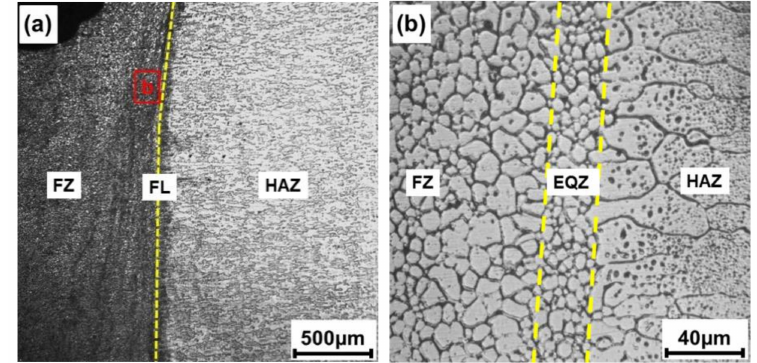
Figure3. Microstructureofthejointtransitionzonewithoutmodificationwelding: ( a )lowmagnification, and ( b ) high magnification.